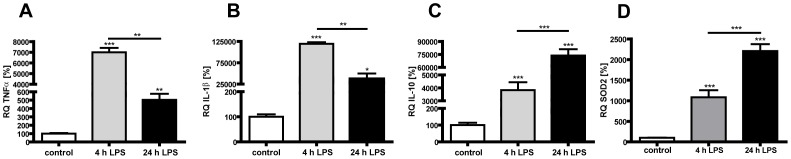
LPS activated microglia cells modulate inflammatory and reactive oxygen scavenger gene expression in a time-dependent manner.Gene expression analysis of co-cultures after 4 and 24 h of LPS-stimulation using quantitative Real-Time PCR show an increased expression of pro-inflammatory genes at 4 h (grey bars) which declines at 24 h (black bars) as shown in (A) for TNFα and (B) IL-1β. Gene expression of the anti-inflammatory cytokine IL-10 (C) and the reactive oxygen scavenger SOD2 is increased at 4 h (grey bars) and increases further at 24 h (black bars). Experiments were performed three times in dublicates. * p<0.05, ** p<0.01 and *** p<0.001; VN: vehicle+normoxia, LN: LPS+normoxia, VH: vehicle+hyperoxia, LH: LPS+hyperoxia.